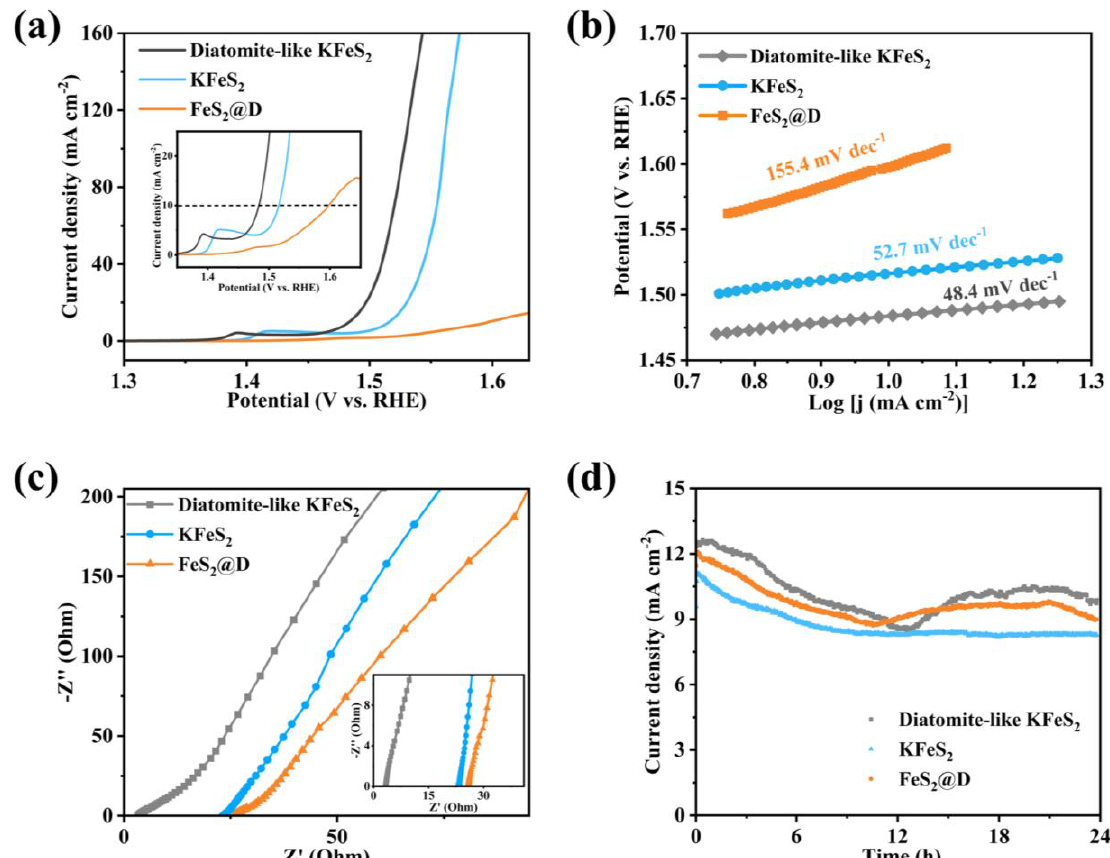
Figure 4. ( a ) LSV plots (the inset is the partial enlargement plot); ( b ) the corresponding Tafel plots; ( c ) comparison of EIS between diatomite-like KFeS 2 , KfeS 2 , and FeS 2 @D (the partial enlargement plot is shown in the inset); ( d ) current – time curves of diatomite-like KFeS 2 , KFeS 2 , and FeS 2 @D for 24 h. Table 2. Various iron-based sulfide electrode materials with their Tafel slopes and overpotentials. Cycling performance was further tested using the time–current method, and the